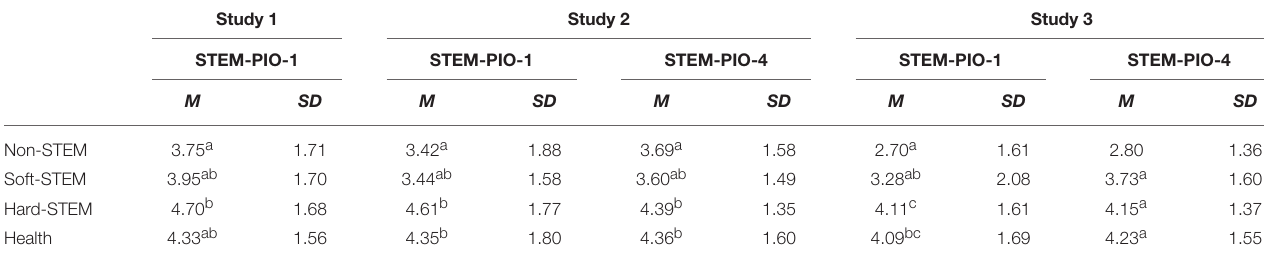
TABLE 3 | Differences in STEM-PIO by major